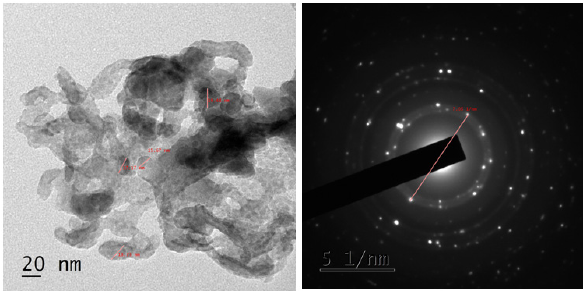
Figure 6: TEM and SAED pattern of ZnO NPs.